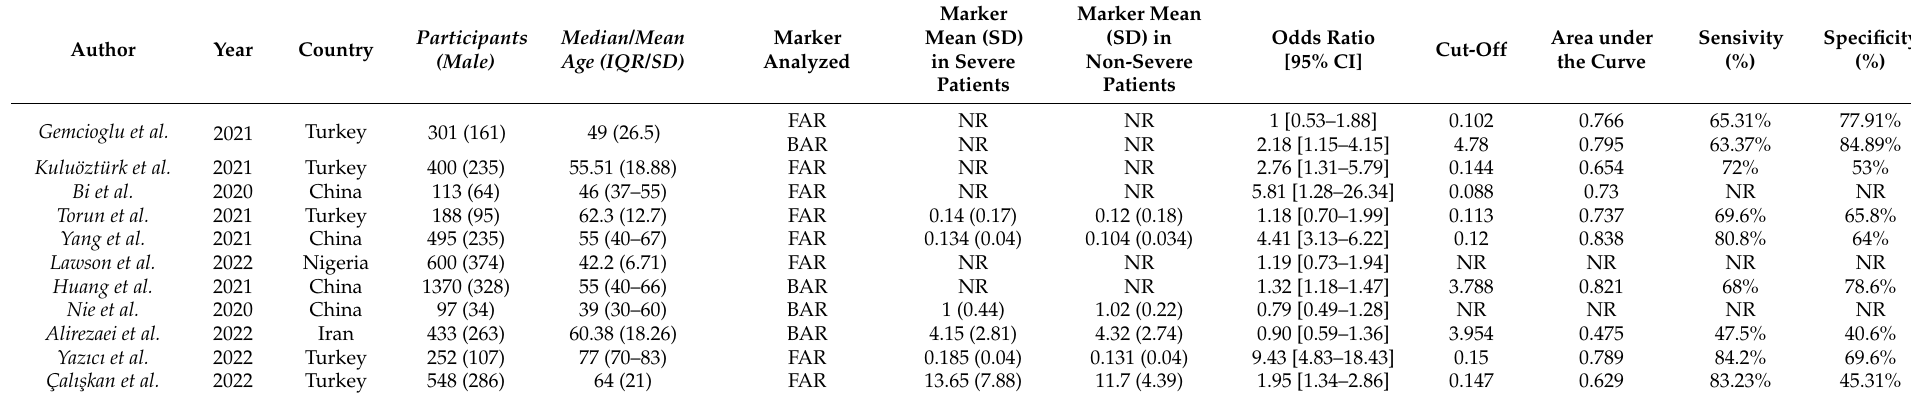
Table 1. Characteristics of the included studies that evaluated severity.